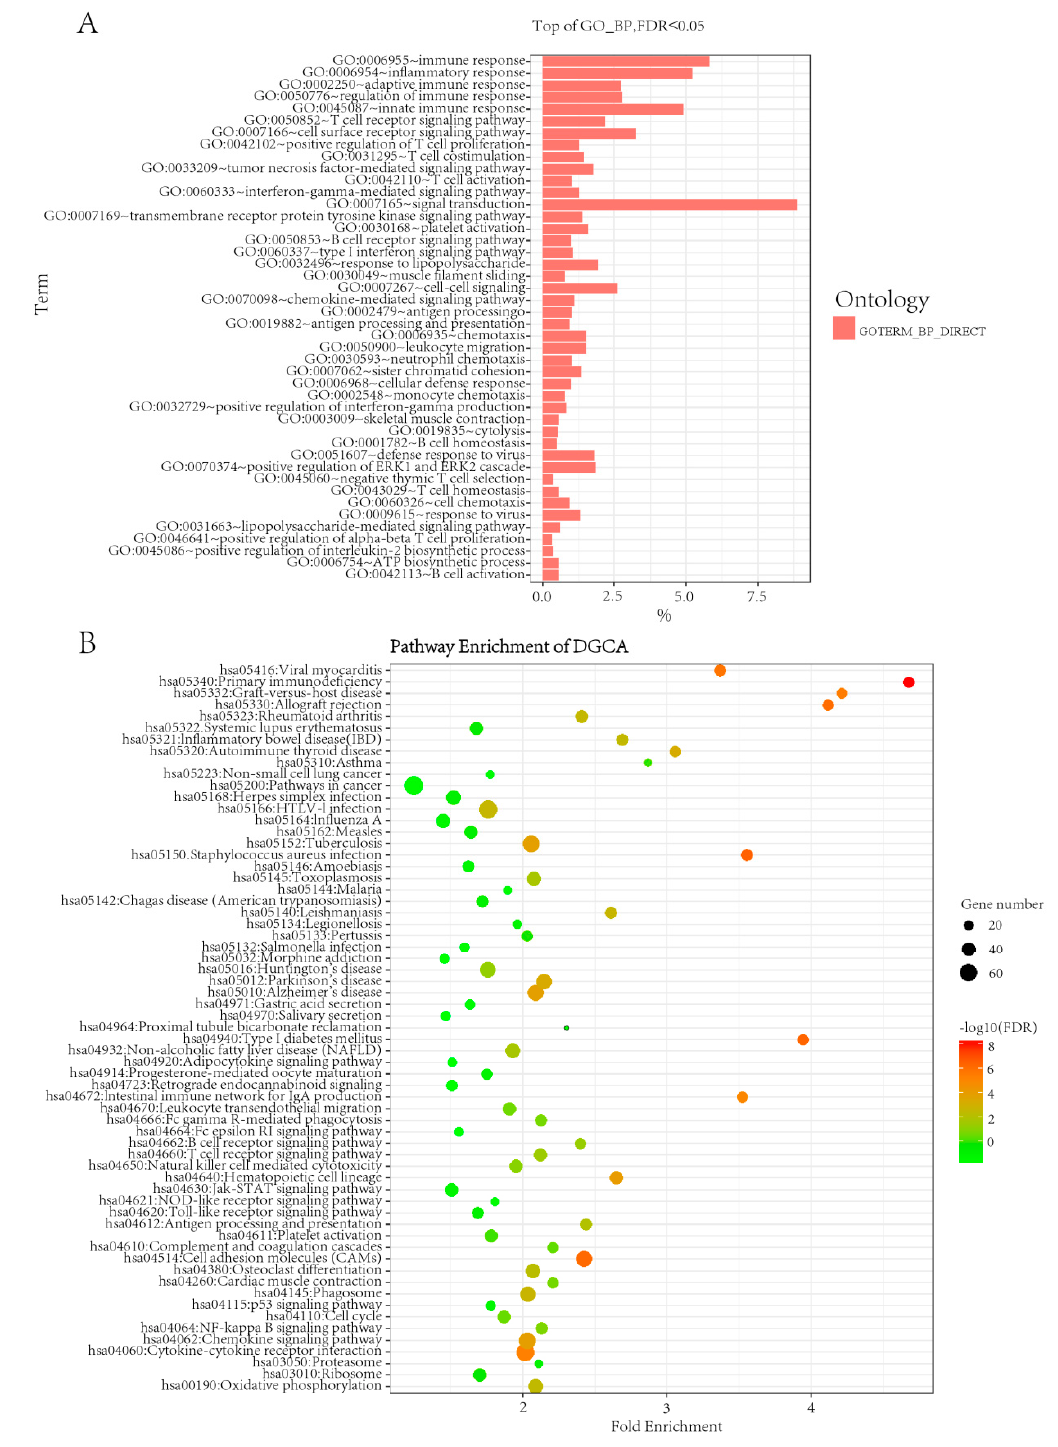
Figure 1. GO and KEGG enrichment of the 2435 unique genes involving in 33,778 significant gene co-expressions identified by DGCA. ( A ) The significantly enriched biological process (GO_BP) with FDR less than or equal to 0.05, where the length of each bar indicates − log10 (FDR) of the corresponding GO BPs; ( B ) KEGG pathway analysis with the row denoting fold change and the size of the dots denoting − log10 (FDR) of the corresponding pathways.